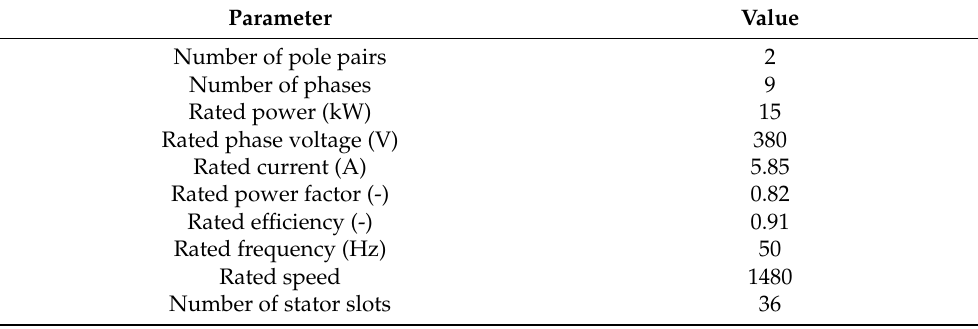
Table 3. Motor parameters.